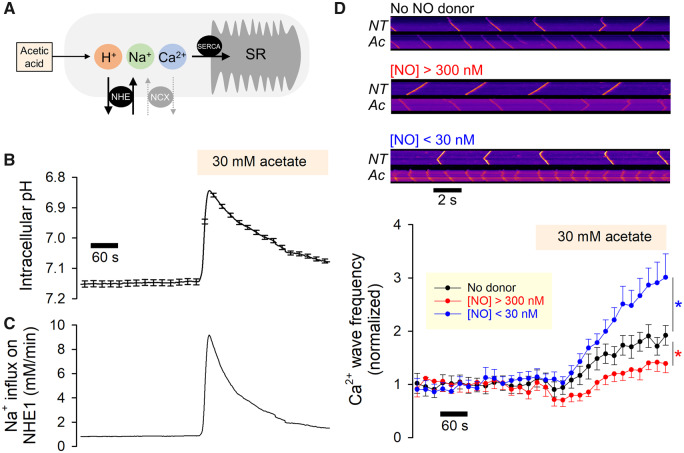
Biphasic regulation of NHE1 by NO affects the propensity of aberrant forms of Ca2+ signalling evoked by mild acidosis. (A) Schematic model of mechanism linking mild acidosis (attained with 30 mM acetate) to sarcoplasmic reticulum (SR) overload. (B) Rat myocytes (loaded with pH-sensitive cSNARF1) under superfusion with Hepes-buffered normal Tyrode with [Ca2+] raised to 5 mM to produce Ca2+ overload and increase the incidence of waves. After a 6 min period in control solution (NT, normal Tyrode), cells were exposed to 30 mM acetate (Ac) which acidifies the myocyte and activates NHE1 (13 cells from two animals). (C) Predicted Na+ influx on NHE1, based on pH-sensitivity of flux determined in Figure 2-2, mapped onto the pHi time course. (D) Rat myocyte loaded with Ca2+ dye Fluo3, imaged in line scan mode. Exemplar line scans are shown for a cell in control conditions, and after 6 min of superfusion with 30 mM acetate. Line scan measurements repeated on cells stimulated with either high or low [NO] released from 5 µM NOC12 (producing [NO]>300 nM) or with 300 µM NOC12 plus 100 µM CPTIO (producing [NO]<30 nM), respectively. Results presented as Ca2+ frequency normalized to baseline level (N = 22 for control, 13 for high [NO], 13 for low [NO]; from five animals). Low [NO] increased Ca2+ wave frequency (P < 0.0001; two-way ANOVA), whereas high [NO] decreased Ca2+ wave frequency (P < 0.0001; two-way ANOVA).